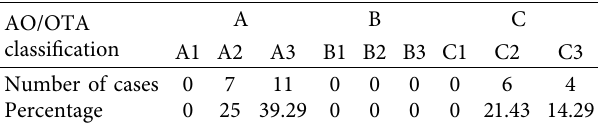
Table 2: Distribution of cases by fracture type according to the AO/ OTA classifcation system.